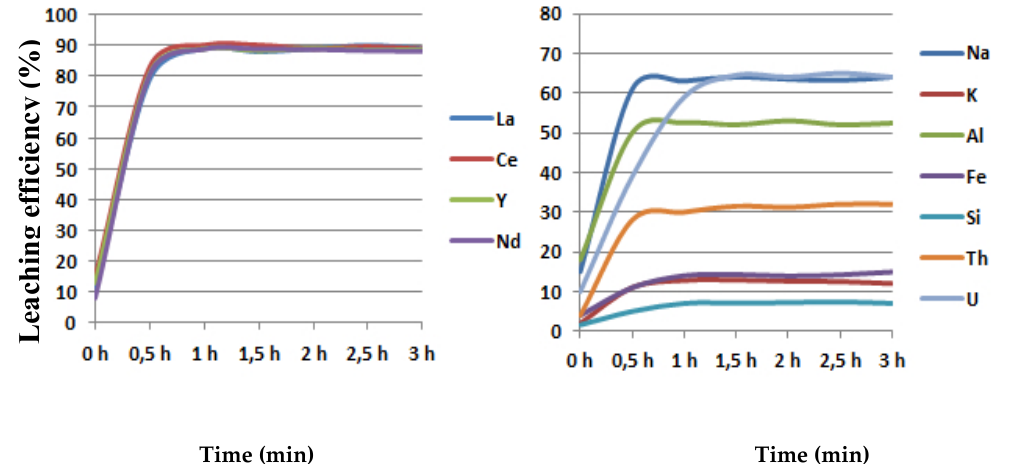
Figure 6. The influence of leaching time on the leaching efficiency.